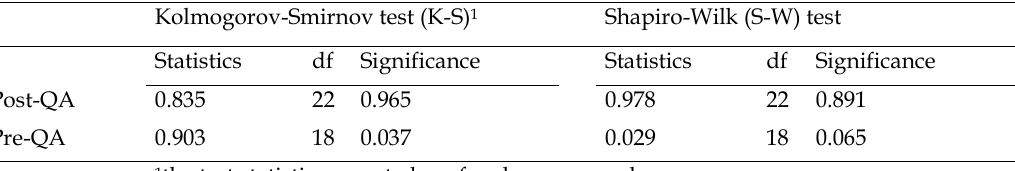
Table 3. The Kolmogorov-Smirnov test (K-S) and Shapiro-Wilk (S-W) test for normality